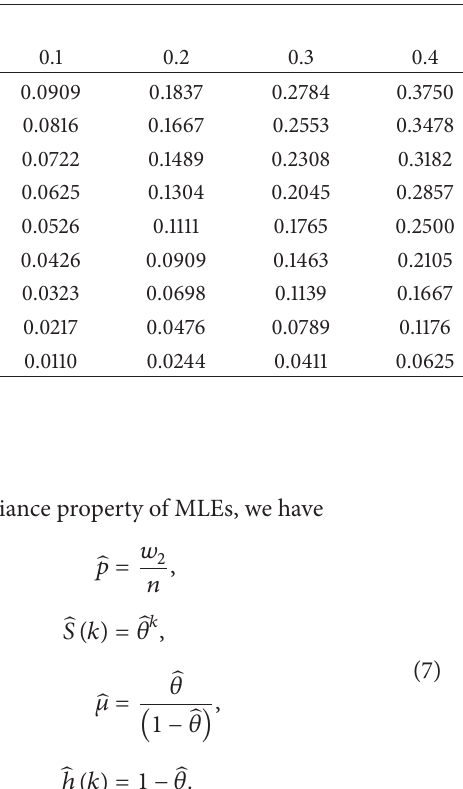
Table 1: Probability of